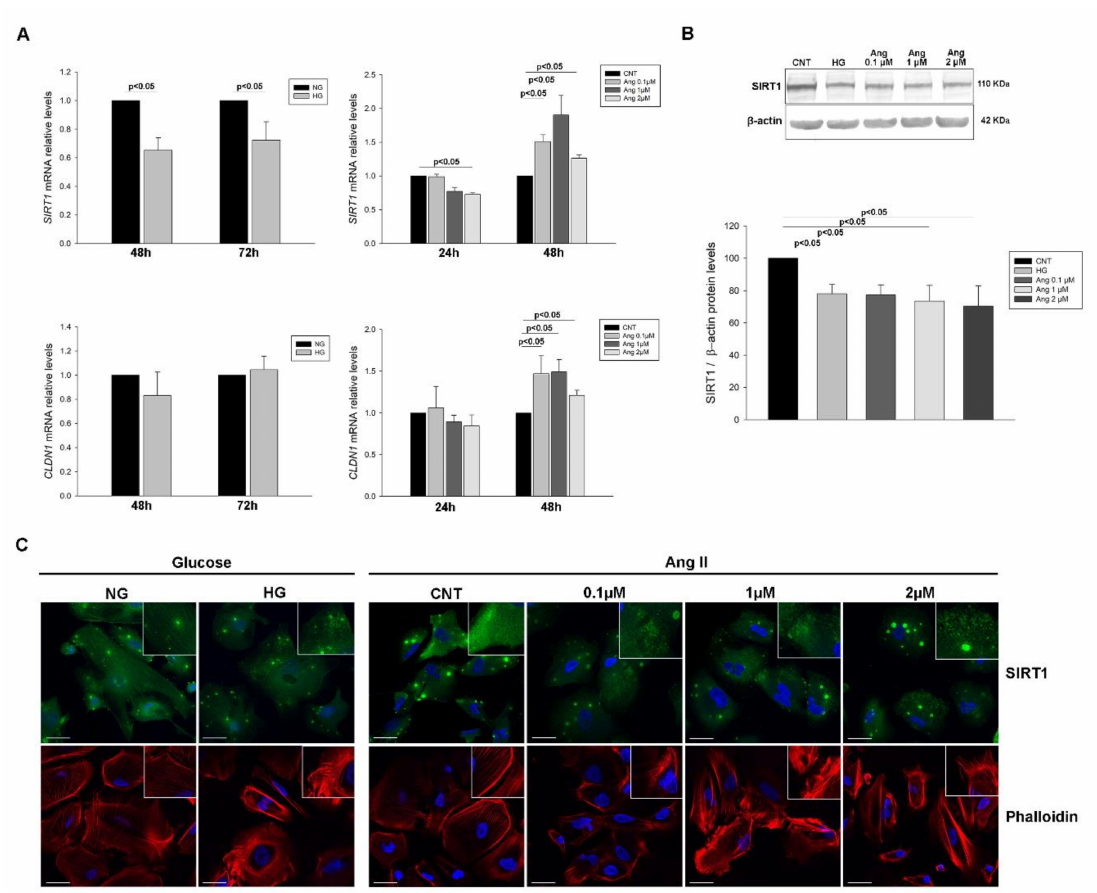
Figure 2. SIRT1 and CLDN1 levels in podocyte cultures subjected to HG and Ang II treatments. ( A ) Bar graphs of the comparison of SIRT1 and CLDN1 mRNA levels between NG and HG and between Ang increasing concentrations at di ff erent treatment times; ( B ) Blots of SIRT1 protein levels in glucose and Ang II treated podocytes; ( C ) Immunofluorescence analyses of SIRT1 in treated podocytes and phalloidin staining of F-actin fibers showing the cytoskeleton dysregulation under treatments. Bars represent mean ± SEM ( n = 6 each group). mRNA levels were normalised to two housekeeping genes and relative expression was expressed in fold change with CNT group values set to 1-fold. Protein levels were previously normalised to β -actin and expressed as arbitrary units, with CNT values set to 100. SIRT1 : Sirtuin 1 gene; CLDN1 : Claudin 1 gene; NG: normal glucose; HG: high glucose; CNT: control; Ang: angiotensin II. Scale bar: 40 µ